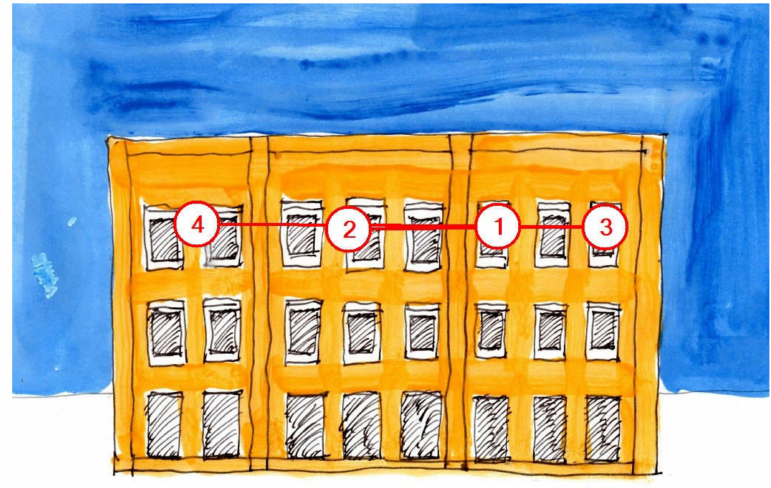
Figure 1. Scanning sequence for Classical / Baroque building.